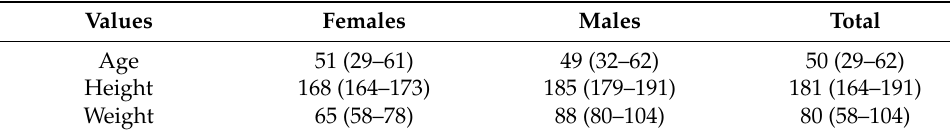
Table 1. Patients’